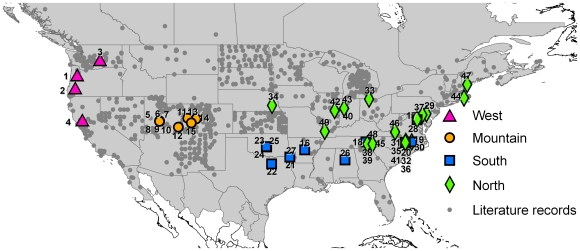
Distribution of Tapinoma sessile North America.Museum and literature collection records (small gray circles), and the 49 localities represented in this study (west – purple triangles; mountain – orange circles; south – blue squares; north – green diamonds).